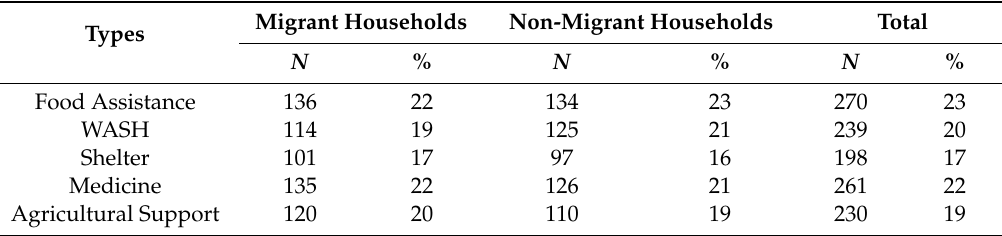
Table 4. Relief received by migrant and non-migrant households.